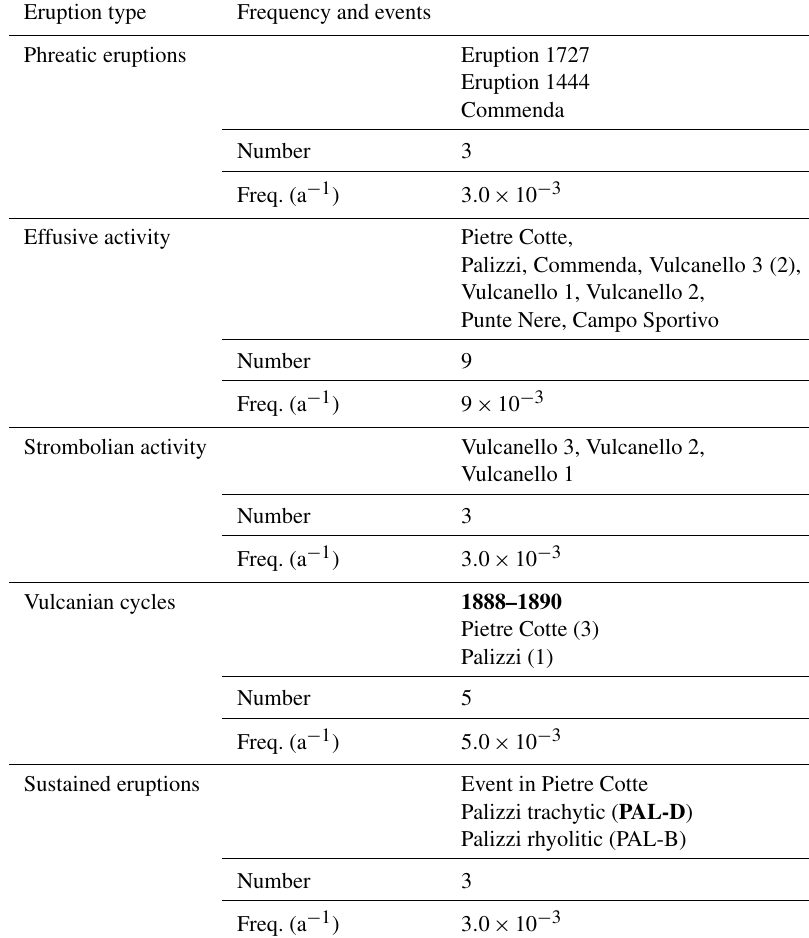
Table 1. Number of observed eruptions for the different types of activity in the last 1000 years on Vulcano island. Values of frequencies and the detailed events for each type are also reported. In bold are the selected scenarios used in Sect. 3.3; based on data from Di Traglia et al. (2013) and De Astis et al. (1997,